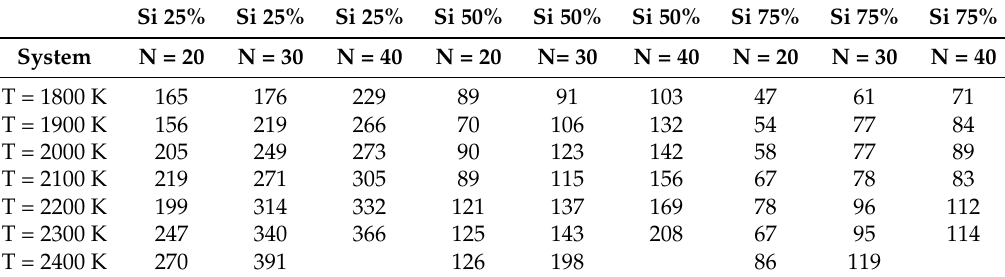
Table 1. Inception times (ns) for Si particles of 20, 30, and 40